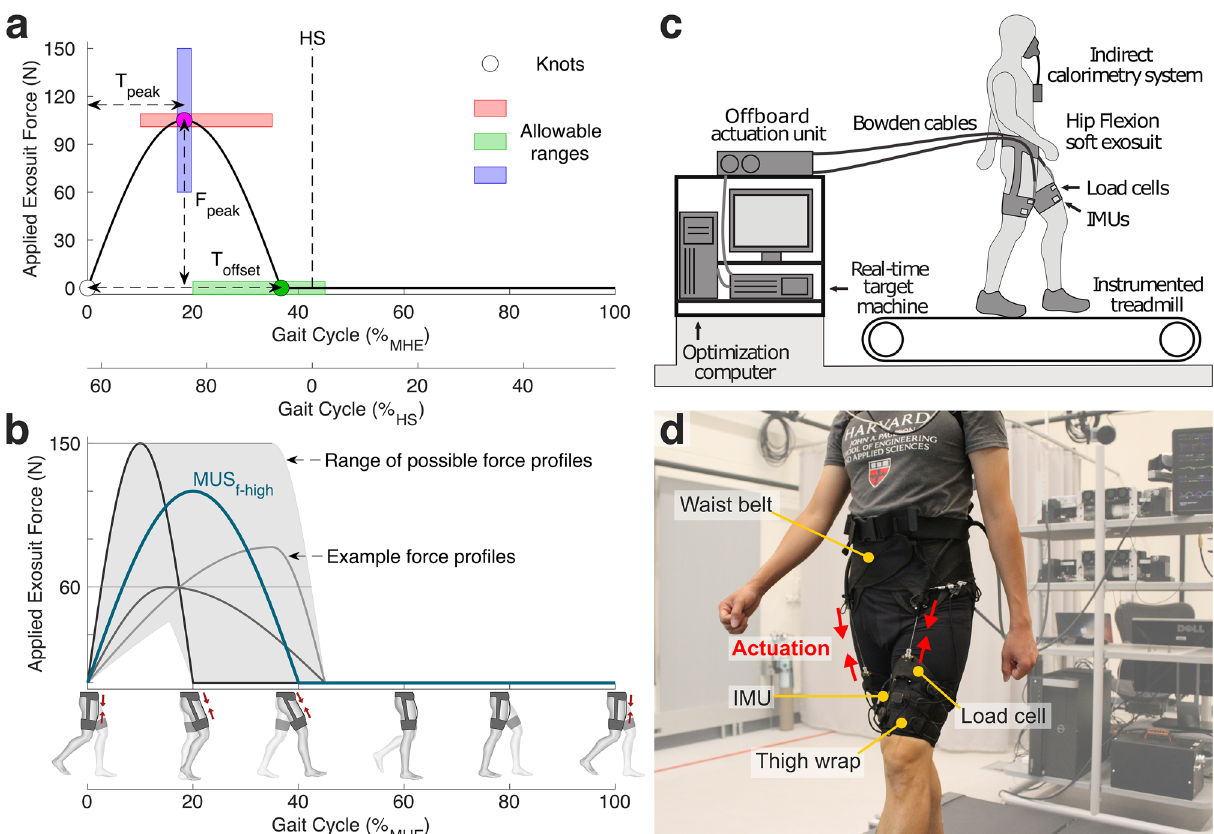
Figure 1. Experimental setup & HIL Parameters. ( a ) Parametrization of hip flexion force profile. There are three knot points (onset, peak, and offset), and a sinusoidal curve is used between knot points. The shaded region represents an allowable range for each parameter. % MHE means the gait cycle segmented by a maximum hip extension (MHE), whereas % HS means the gait cycle segmented by a heel strike (HS). A vertical dashed line indicates the heel strike. ( b ) Examples of possible assistance profiles and a fixed muscle inspired profile ( MUS f − high ). ( c ) Experimental setup with an off-board actuator. ( d ) Detailed view of components of hip flexion exosuit.